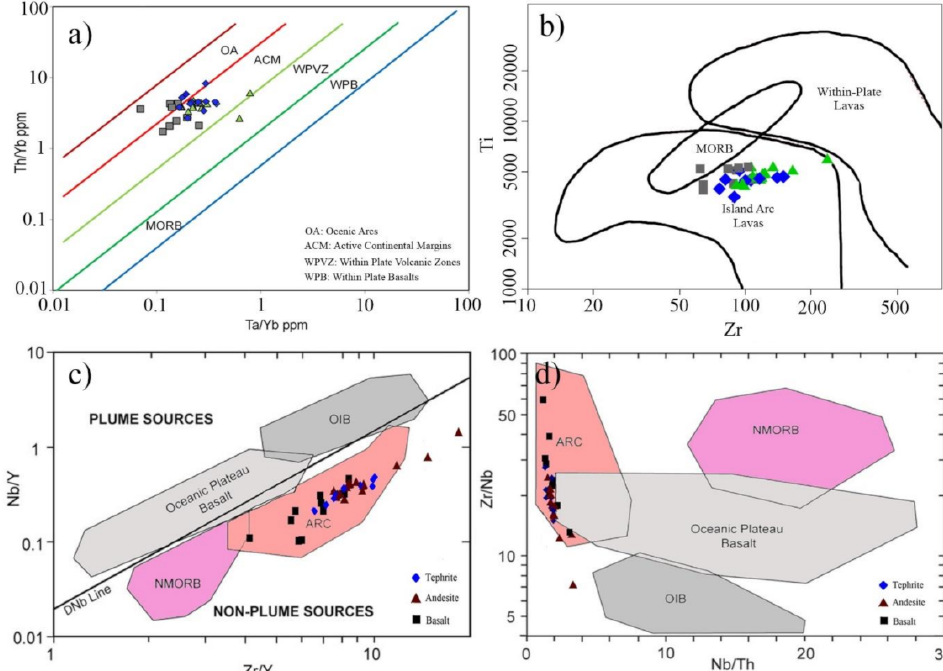
Figure 15. ( a ) Ta/Yb versus Th/Yb diagram [118], ( b ) Zr versus Ti diagram [60], ( c ) Zr/Y versus Nb/Y diagram [119] and ( d ) Nb/Th versus Zr/Nb diagram